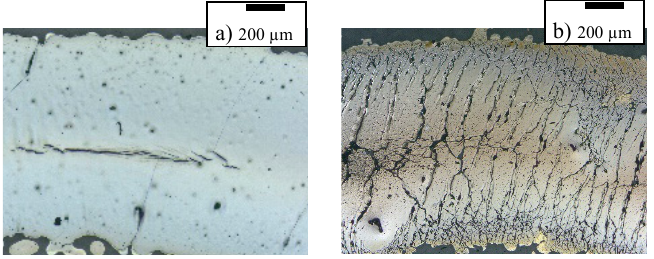
Figure 3. Inkjet-printed line before ( a ) and after ( b ) stretching 2000 times. After stretching, many small cracks occur within the printed surface.